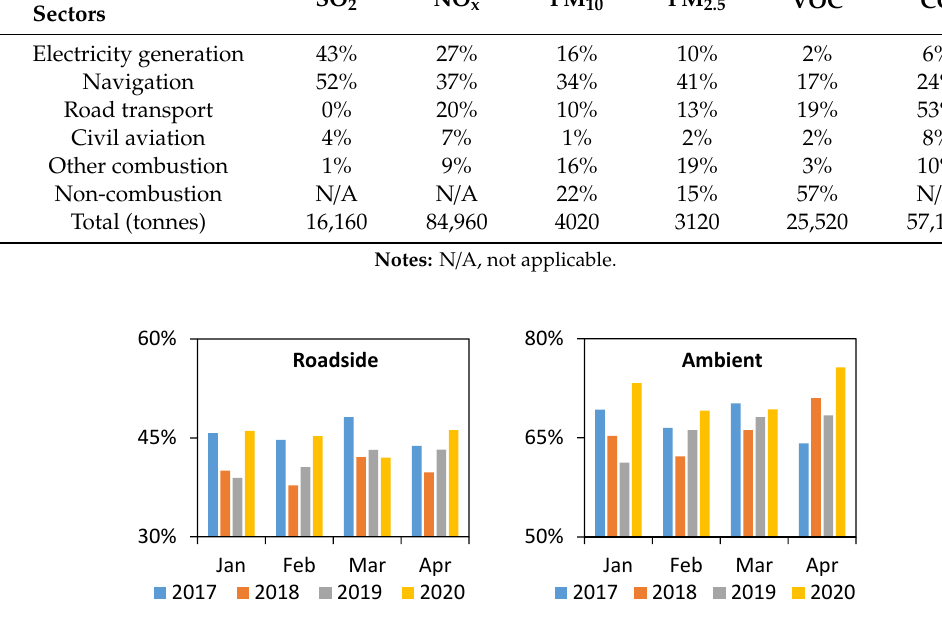
Figure 3. Average roadside and ambient NO 2 /NO x ratios.